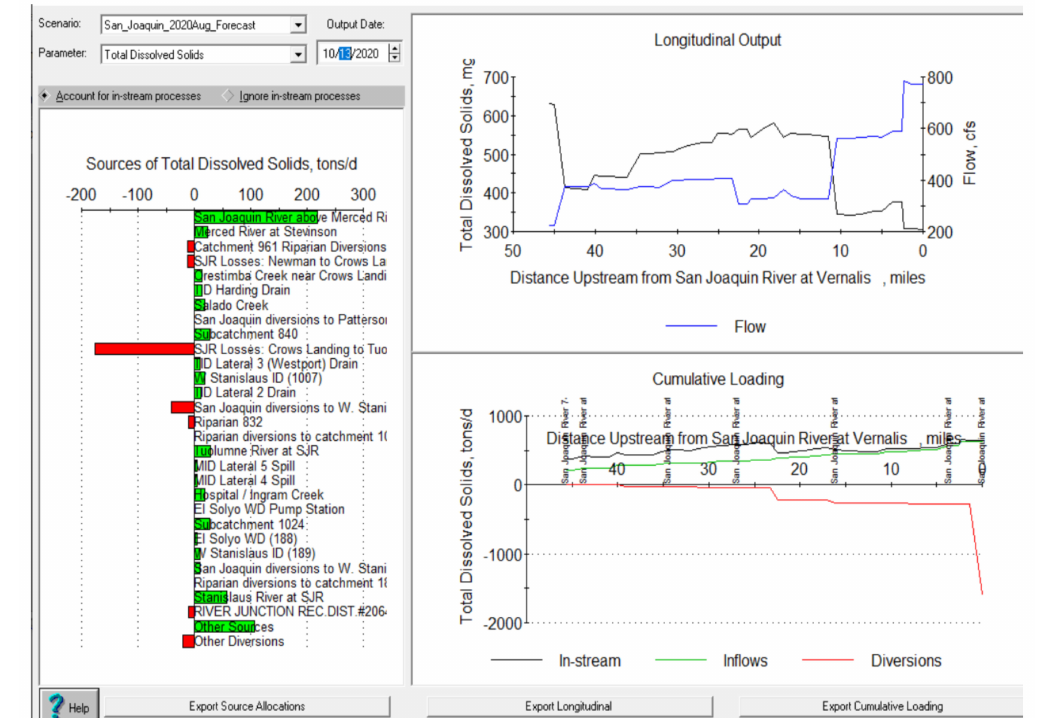
Figure 3. A unique feature of the WARMF model is the availability of customized model outputs such as the “Gowdy” output (named after its developer) shown here. This depicts a Lagrangian view of the SJR at any point in time showing the major inflow to and diversions from the river approximately every 1 mile (800 m) along its main reach as well as the incremental flow 2 and EC concentration from the origin at Lander Avenue to the EC compliance monitoring station at Vernalis